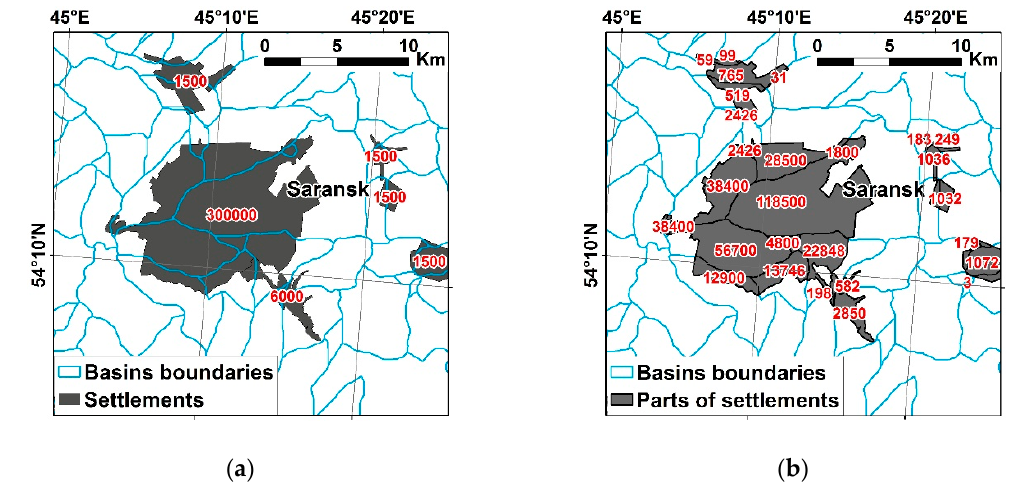
Figure 4. Calculation of the population in parts of settlements located in the different basins: ( a ) population in settlements; ( b ) population in the parts of settlements belonging to the different basins.